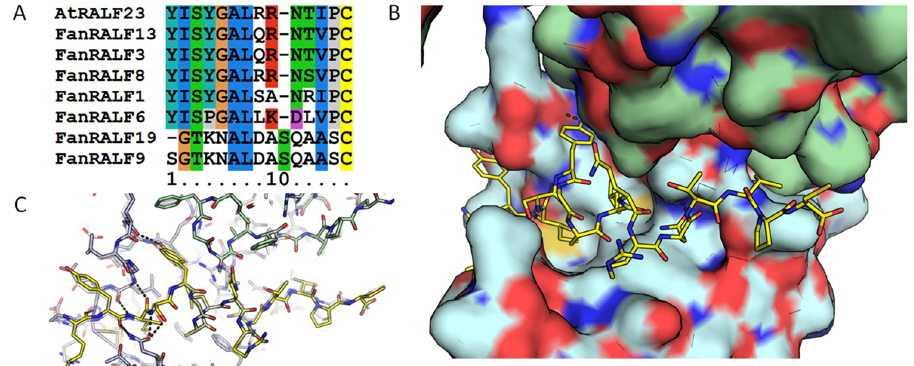
Fig 4. Model of Fan RALF3, Fan MRLK47 and LLG2. (A) multiple sequence alignment of Fan RALFs and At RALF23. (B) Model of the ternary complex of Fan RALF3, Fan MRLK47 and LLG2 based on At complex (PDB:6a5e). C. overlay of the Fan complex model and the At complex, showing high conservation of both the RALF and the two receptors.